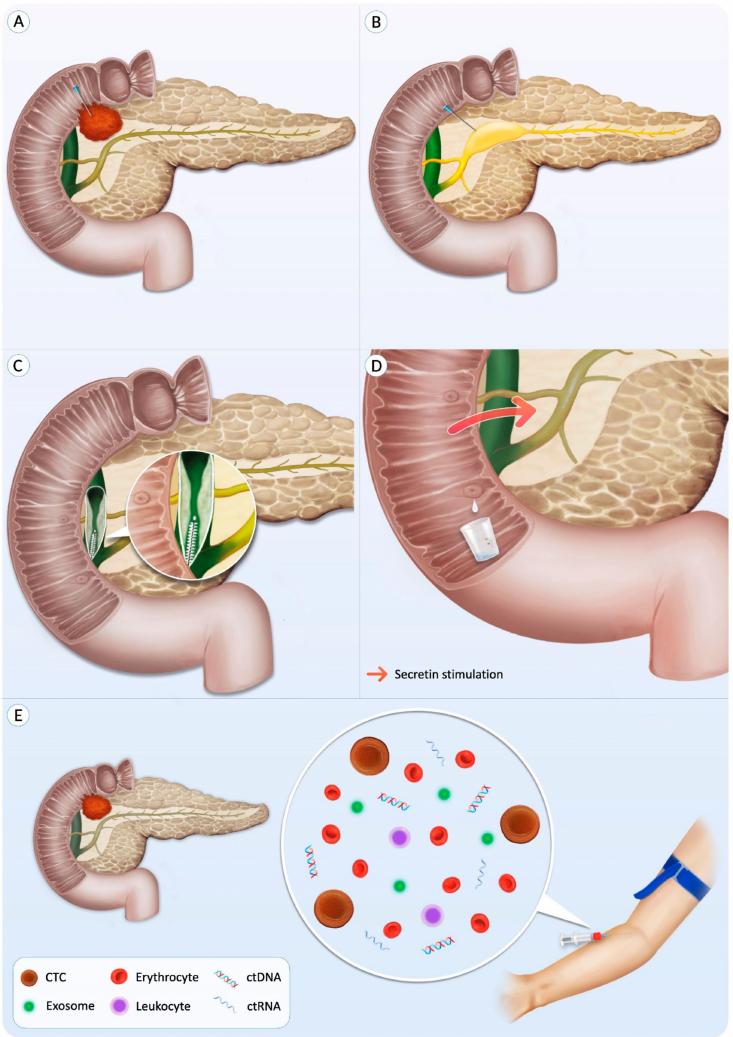
Figure 1. Next-generation sequencing can be performed on distinct small biopsies, including fine- needle aspiration of solid ( A ) and cystic ( B ) pancreatic masses, biliary brushings of biliary tract strictures ( C ), pancreatic juice collected from the duodenum ( D ), and blood-based liquid biopsy ( E ). Firstly, NGS could help clarify indeterminate pancreatic or biliary cases by